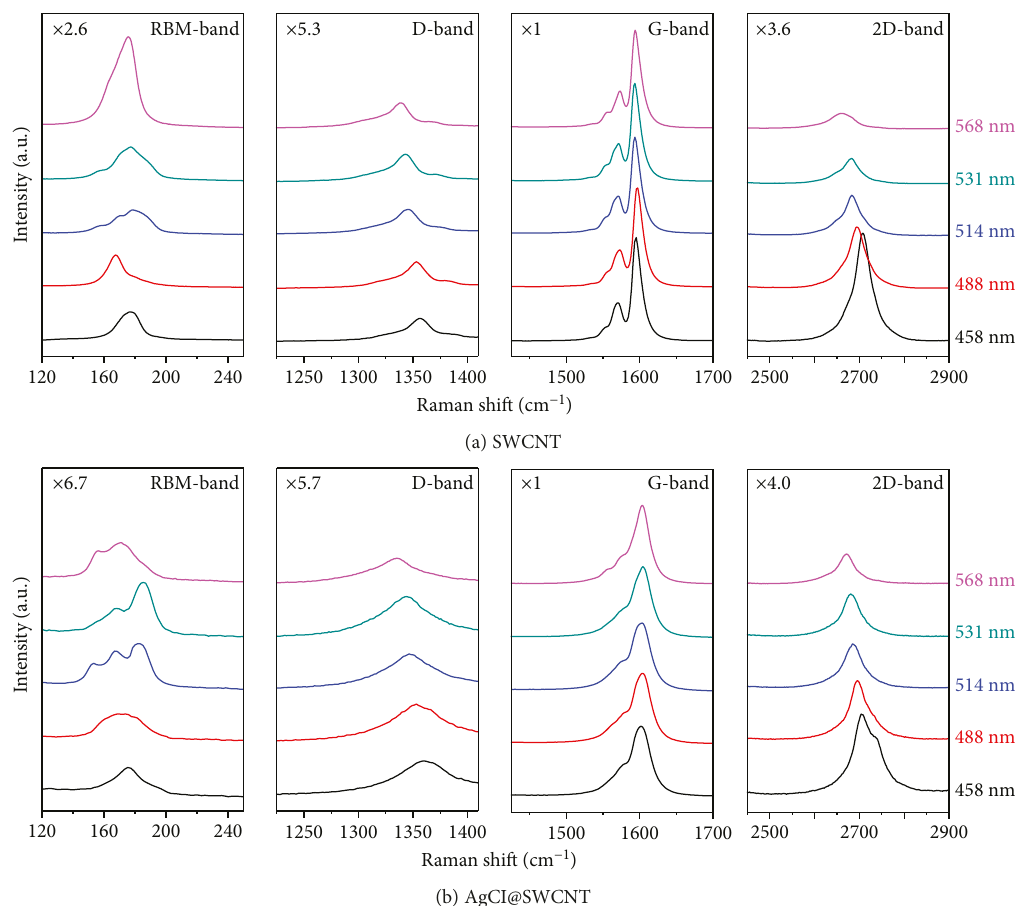
Figure 2: The RBM, D, G, and 2D-bands of Raman spectra of the pristine (a) and AgCl- fi lled (b) SWCNTs acquired at di ff erent laser wavelengths. The spectra were normalized to the area intensity of the G-band and o ff set for